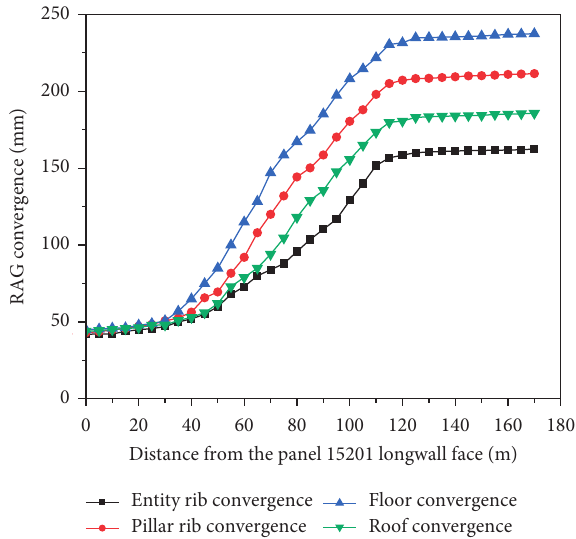
Figure 19: Measured convergences in the 15202 tailgate after using the proposed